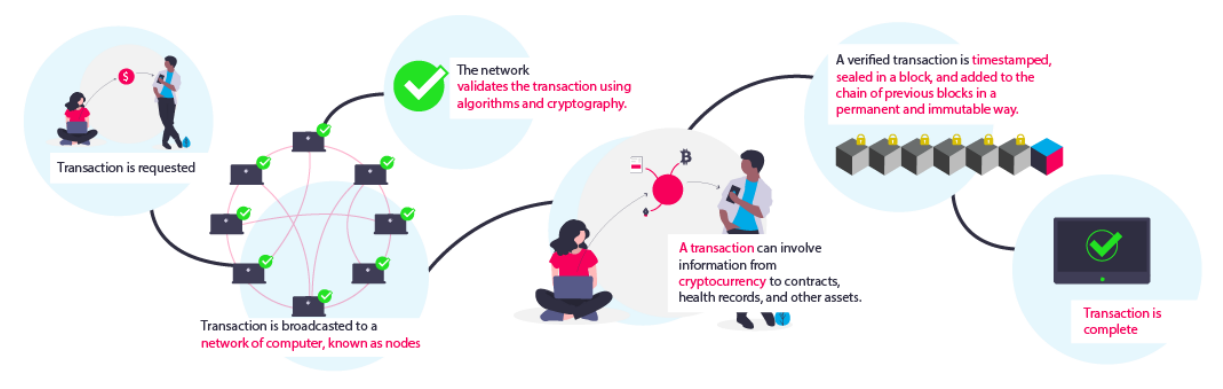
Figure 1. Flow of a transaction in the